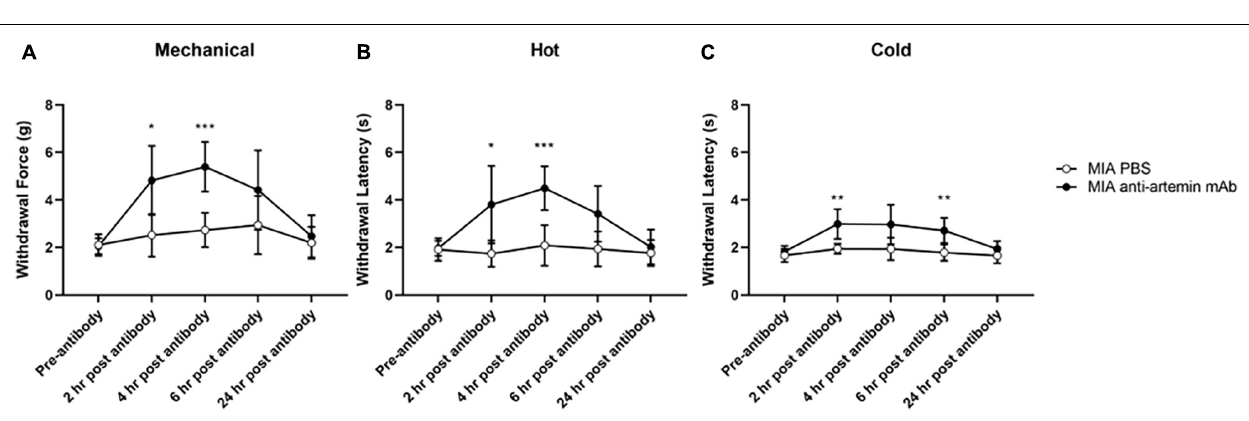
FIGURE 5 | Artemin-induced hypersensitivity to mechanical, heat, and cold stimuli. Mice that received artemin had significantly reduced withdrawal latencies to mechanical (A) , heat (B) , and cold (C) compared to mice that received saline at 4-h post-injection. Withdrawal latencies to the hot and cold stimuli were also significantly lower at 2-h post-artemin injection, compared with the saline-injected group. Data are represented as mean ± SD (** p < 0.01; *** p < 0.001). For mechanical hypersensitivity artemin ( n = 8) and saline ( n = 8). For thermal hypersensitivity artemin ( n = 9) and saline ( n = 9). Two-way ANOVA with repeated measures and Geisser–Greenhouse and Sidak corrections.